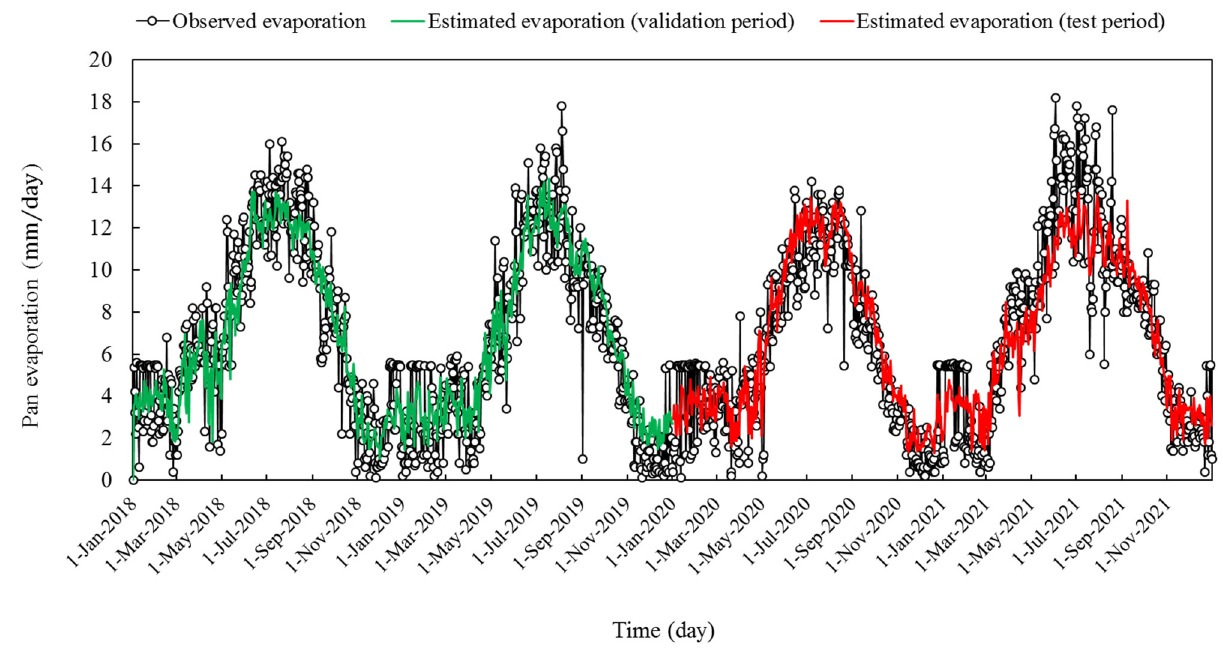
Figure 6. Time series plots of the MLP outputs learned by Bayesian regularization algorithm, and the observational pan evaporation. observational pan Table 5. Evaluation metrics for the pan evaporation modeling of MLP, learned by scaled conjugate gradient algorithm (MLP ‐ SCG).